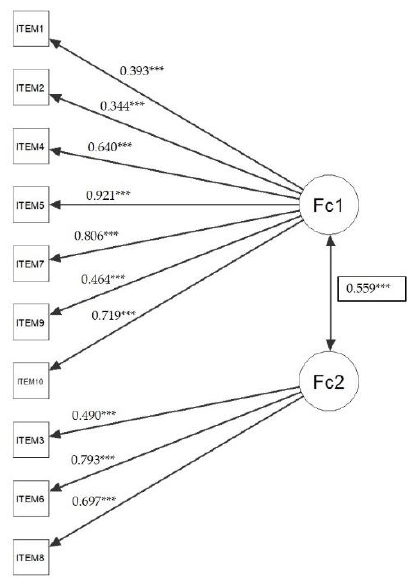
Figure 2. Confirmatory factor analysis. Chi-square = 57. 100 df. = 34, p = 0.008; CFI = 0.936; TLI = 0.915; SRMR = 0.0615; RMSEA = 0.0782 (lower CI = 0.0401; upper CI = 0.113). *** p < 0.001